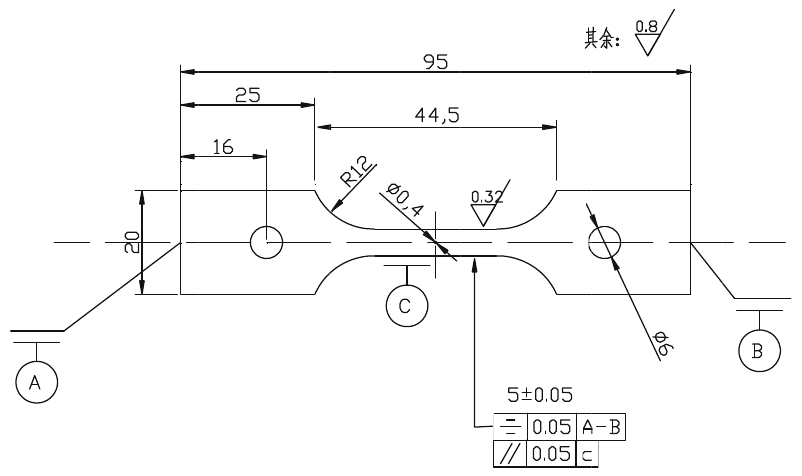
Figure 2: Specimen with a single hole.